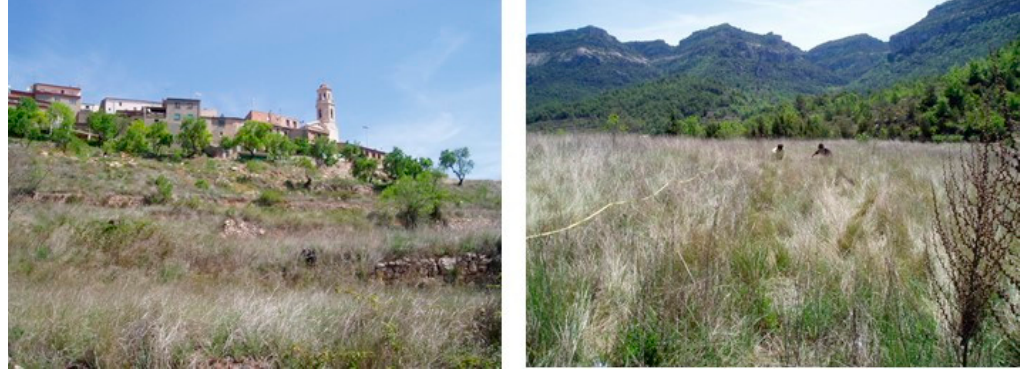
Figure 1. Photographs of the abandoned terraces and the village of Capafonts and of our study plot with the Prades mountains in the background (2017).